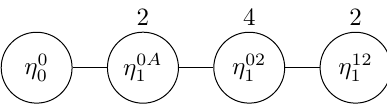
\ T \ V ( f ), Resolution I. 2 -model at S